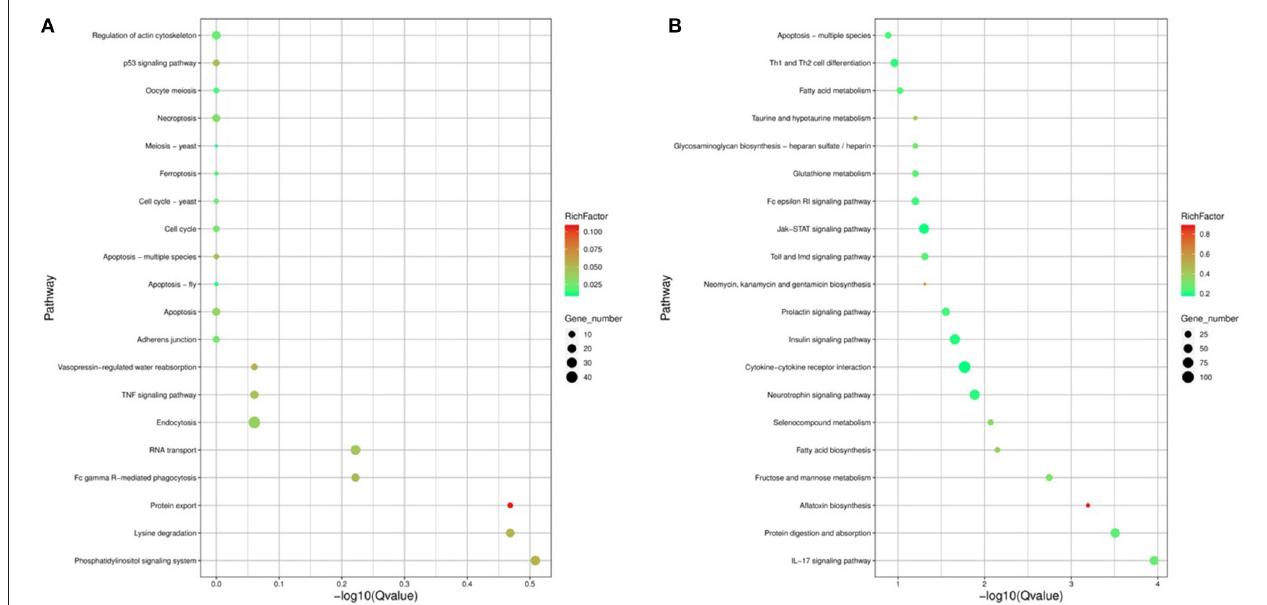
FIGURE 5 | The 20 enriched KEGG for the identified DEGs and target genes of DEMs in FP-HY vs. FP-LY. The abscissa and ordinate represent the -log 10 Qvalue of enriched genes and the KEGG pathways, respectively. Rich factor refers to the ratio of the number of differentially expressed gene and the number of annotation genes enriched in this pathway term. The size of the circle in the figure indicates the number of differential gene enrichment in the pathway. KEGG, Kyoto Encyclopedia of Genes and Genomes. (A) KEGG enrichment pathways for DEGs in FP-HY vs. FP-LY. (B) KEGG enrichment pathways for target genes of DEMs in FP-HY vs.